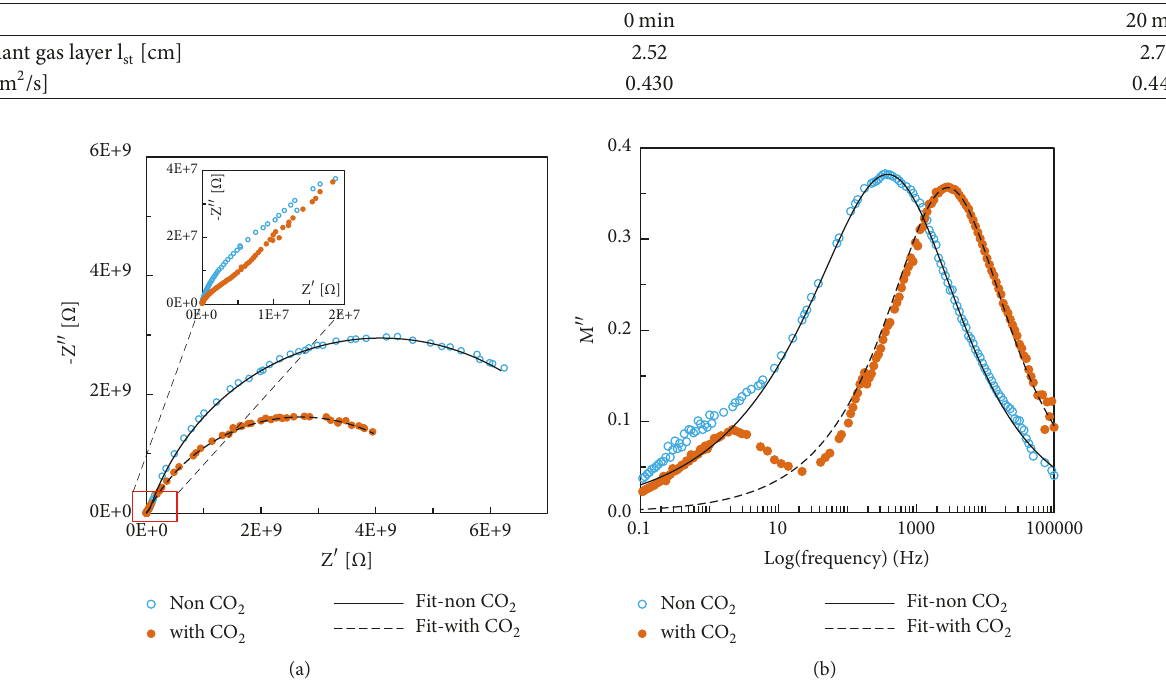
Table 2: Effective diffusion coefficients of mixed gas in the cell system at 383 K.